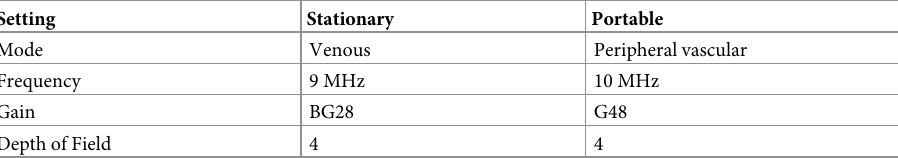
Table 1. Description of ultrasound diagnosis equipment used in this study.